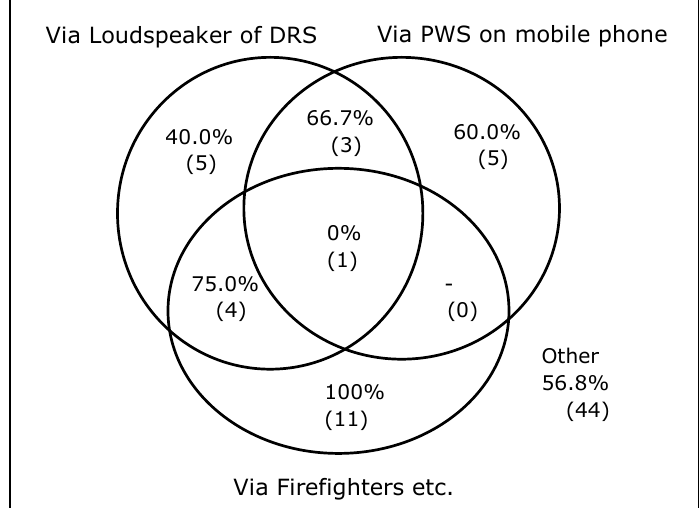
Figure 16. Early evacuation rate and duplication effects of major communication channels, n = 73. A number in parentheses is the number of people in the category.